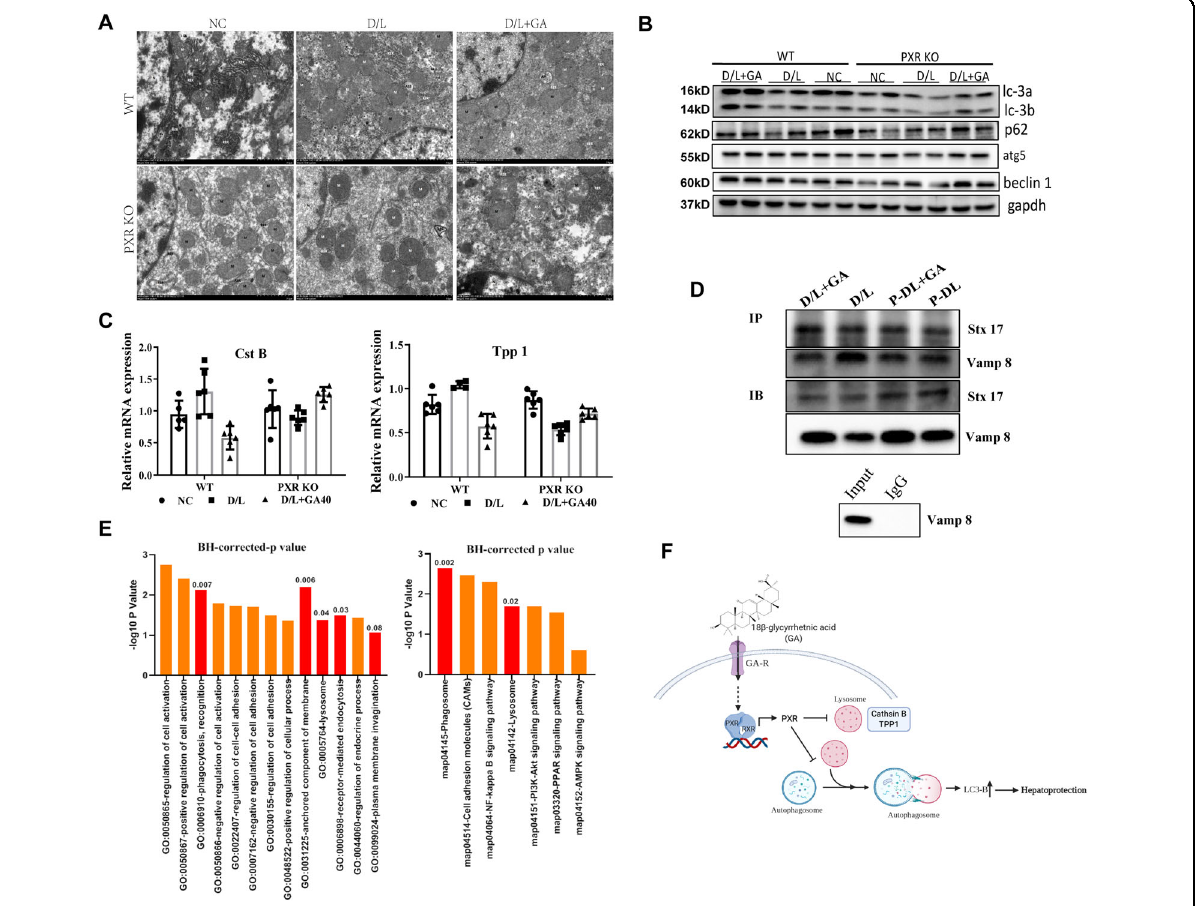
Fig. 6 Knockout of PXR interferes with the autophagy regulation of GA in acute liver injury. Wild-type (WT) and PXR-null mice were treated with or without GA (40 mg/kg) for 5 consecutive days, and D/L was intraperitoneally administered at 4 h before the mice were sacri fi ced. A Transmission electron micrograph of liver sections. B The hepatic protein levels of autophagy-related biomarkers, and C the mRNA levels of autophagolysosomal-related genes (Cst B and TPP1) in mice were determined. D Co-IP of Vamp 8 and Stx17 in D/L- and/or GA-treated WT and PXR- null mice. IB, immunoblot. E Gene Ontology and KEGG enrichment analysis of SDEGs meeting a prede fi ned threshold with a BH-corrected P -value < 0.05 in WT and PXR-null mice. F Pattern diagram of GA regulating autophagy through